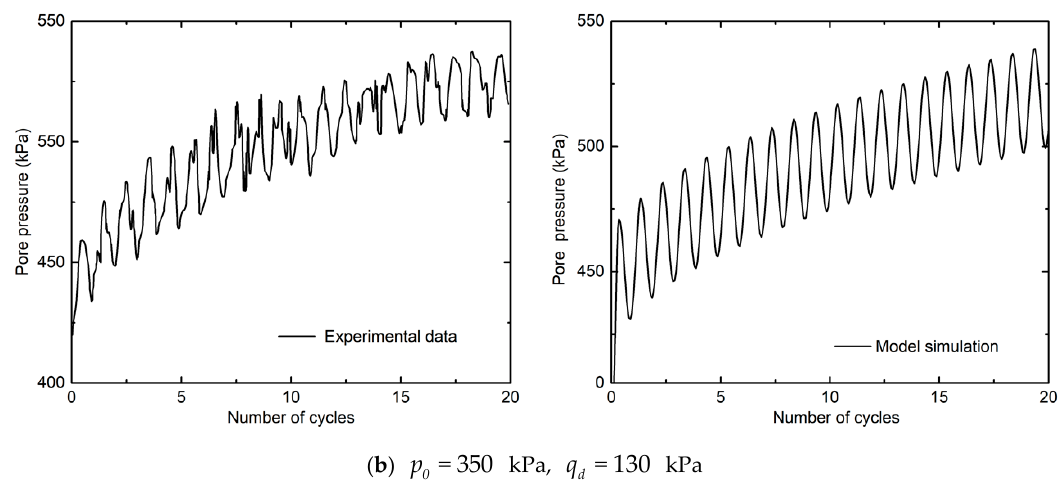
Figure 6. Comparison of pore water pressures between the model simulation and measured data.